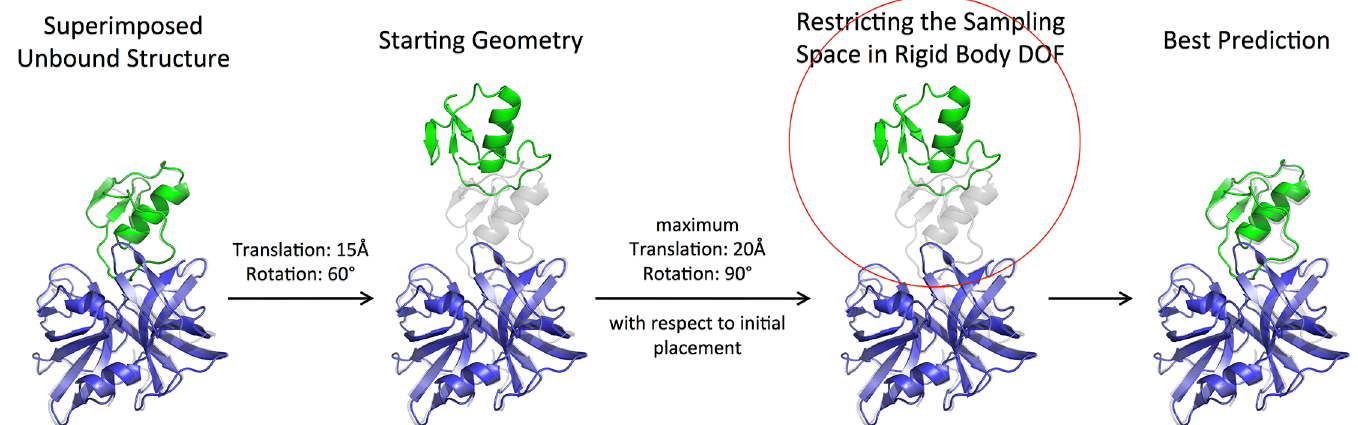
Fig 1. Docking refinement conditions. Each docking starting geometry was generated by an initial random translation of one unbound partner from the geometry in the complex by 15 Å and random rotation of 60° (compare green displaced and grey cartoon representations). During the docking search translation and rotation of one partner with respect to the other was restricted relative to the starting geometry by 20 Å and 90° (indicated by red circle),